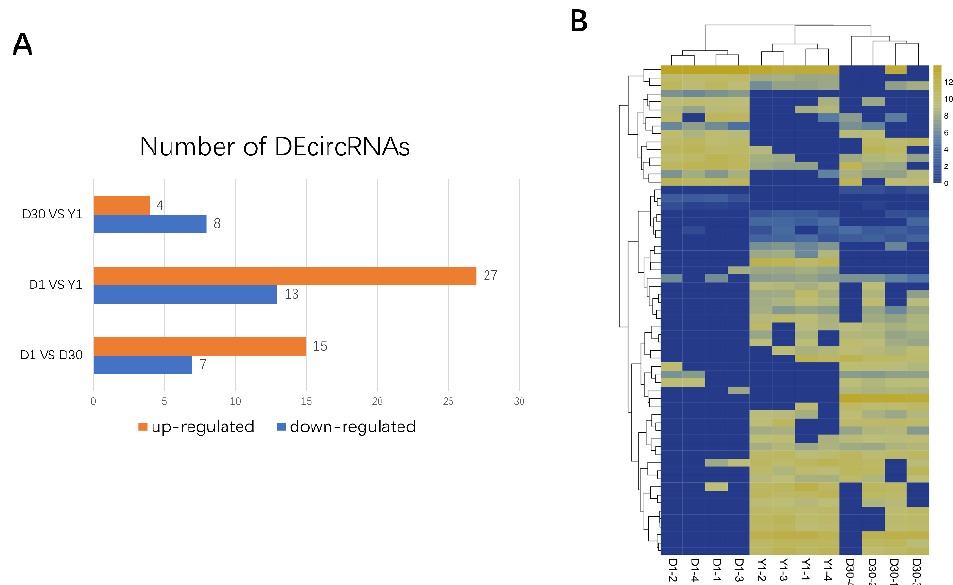
Figure 4. Identification and function analysis of DEcircRNAs in goat perirenal fat. ( A ) Numbers of DEcircRNAs in three stages of perirenal fat, the differences were compared to the latter group. ( B ) Heatmap clustering shows all DEcircRNAs in three different stages.